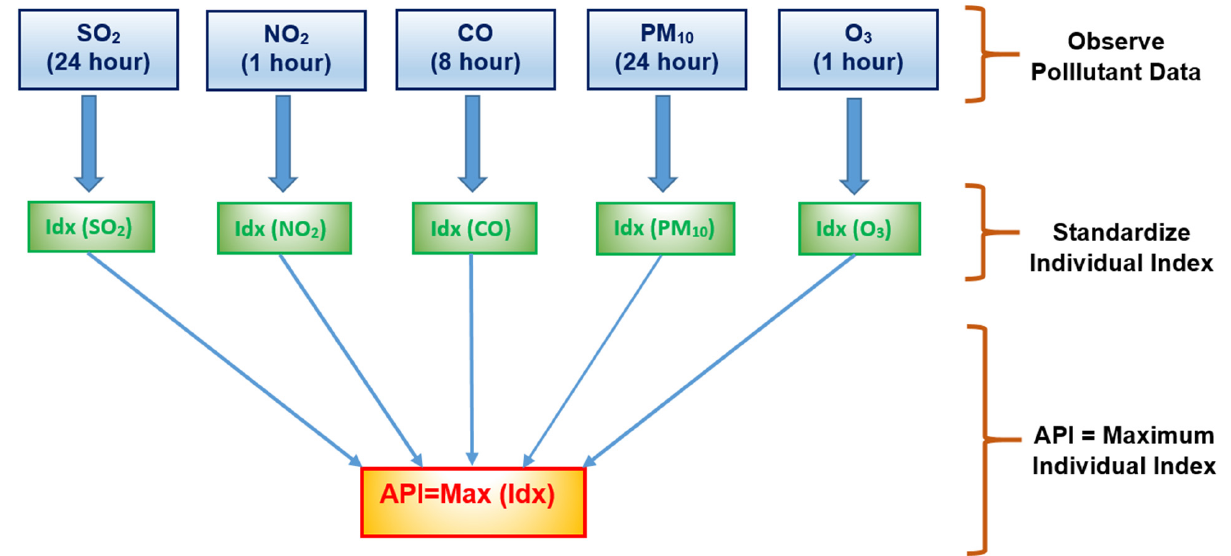
Figure 2. Process of determining the API value [41]. Table 1. API values and their corresponding health effects and advice.